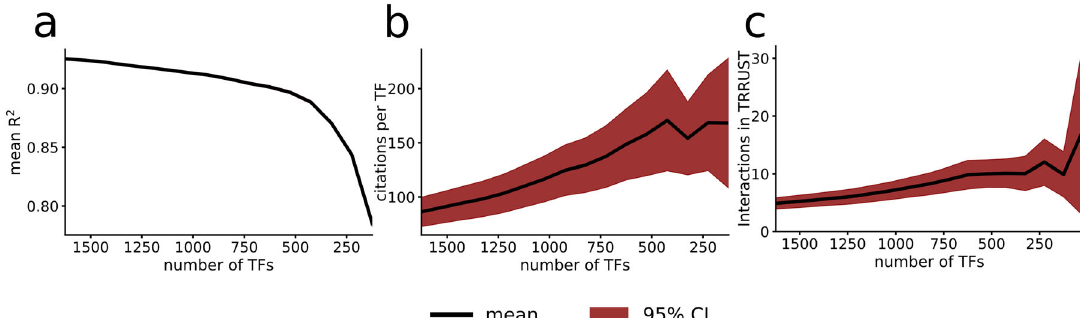
Fig. 4 Functional Hierarchies in Model Input. a We found the explanatory power on test data to decrease as the number of TFs were removed from the model. Particularly, we found around 500 TFs to carry a greater predictive power, as the explanatory power after that point more rapidly decreased. b We measured the median number of scienti fi c studies at each iteration of our backward-selection algorithm, and found that as the number of input TFs decreased, the more studied were those that were left. c The TFs that were identi fi ed as more important also had more recorded interactions in the TRRUST